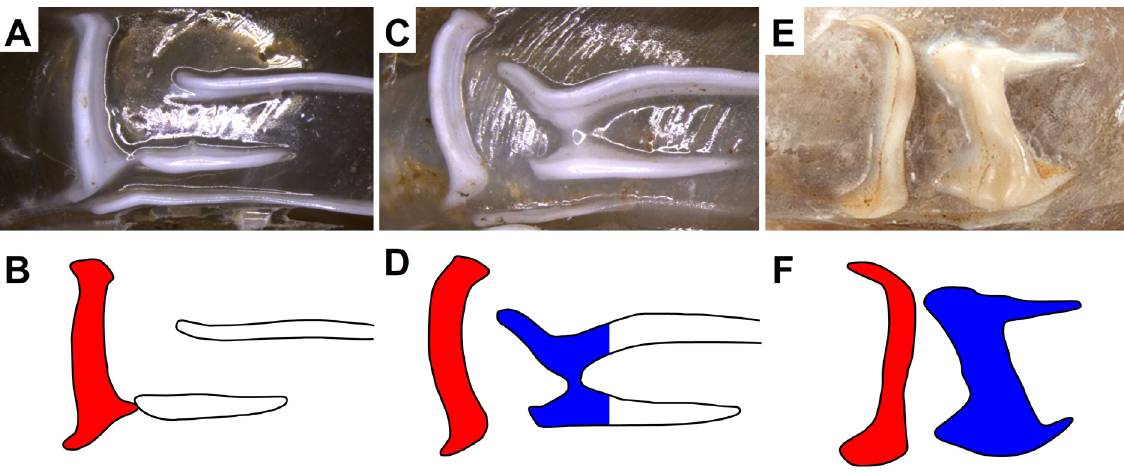
Fig. 5. Photos (A, C, E) and schematic drawings (B, D, F) of parietal plicae and lamellae of Plectopylinae Möllendorff, 1898. A–B . Chersaecia shanensis (Stoliczka, 1873), loc. 20091018C (PGB, ex coll. Ohara). C–D . Chersaecia perrierae (Gude, 1898), loc. 20091019A (PGB). E–F . Chersaecia magna (Gude, 1897) comb. nov., holotype (NHMUK 1922.8.29.37). Posterior lamella indicated with red colour, anterior lamella and homologous structures indicated with blue. Not to scale. Photos: B. Páll-Gergely (A, C) and H. Taylor